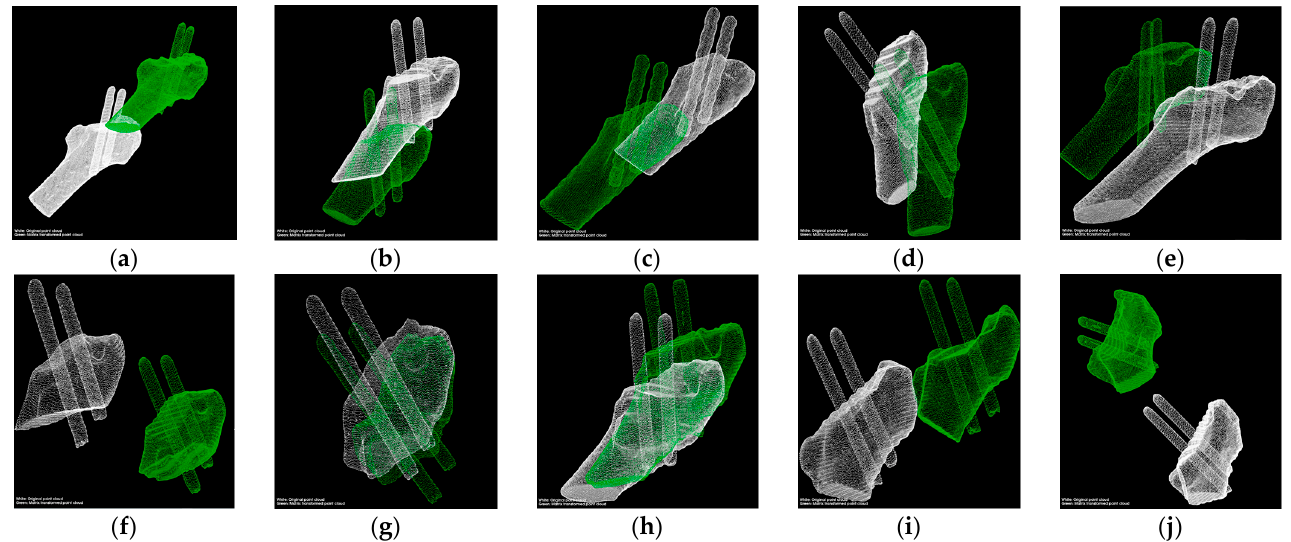
Figure 15. 3D point clouds preprocessing. ( a – j ) are the point clouds of the 10 cases without performing alignment, respectively. The white point cloud is generated based on postoperative CT images, and the green point cloud is generated based on CT images scanned after the one-year recovery period.